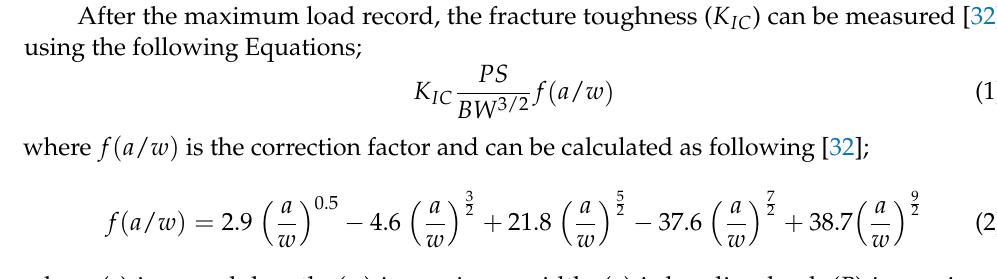
Figure 5. ( a ) specimen geometry, ( b ) test setup for single edge notch bending (SENB).